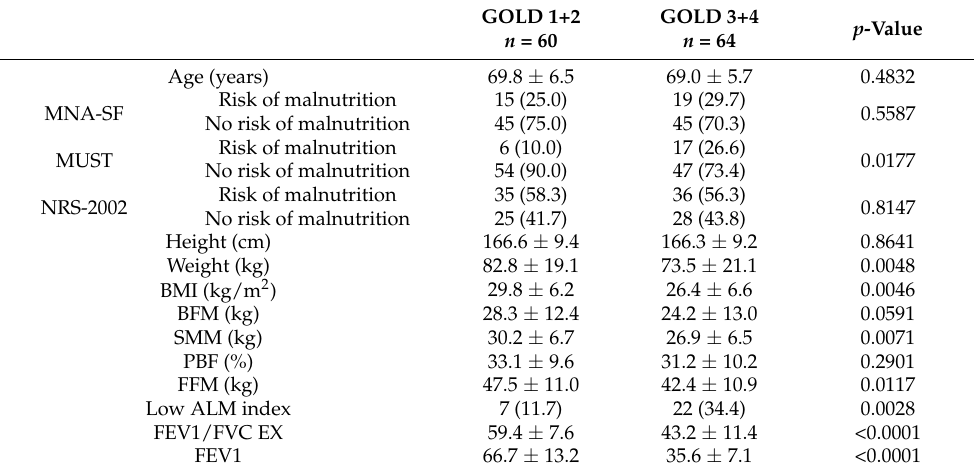
Table 1. Characteristics of study population according to the severity of